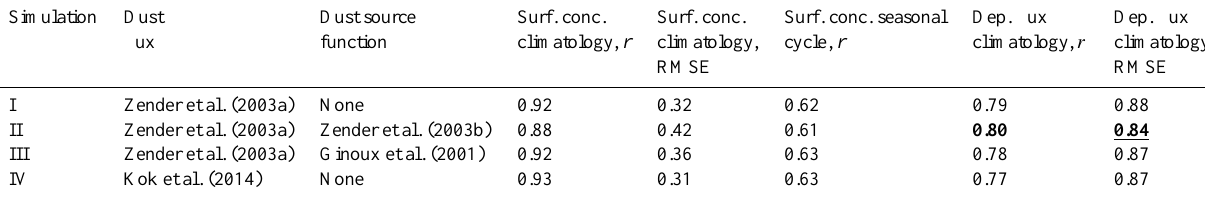
Table 2. Statistics of the comparison of the four CESM simulations against data sets taken further from source regions, namely dust surface concentration measurements and dust deposition fluxes. Simulations and measurements are compared with respect to their climatology for both data sets and their seasonal cycle for the surface concentration. Statistically significant improvements (see Sect. 2.4) of simulations II–IV relative to the “control” simulation I are indicated with bold font. Additionally, simulation results that are statistically significantly improved over the results of each of the other three simulations are both bold and